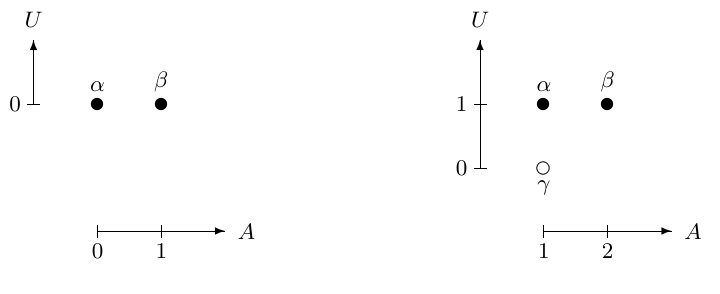
Figure 3: Classification of simply real dihedral and pure cubic